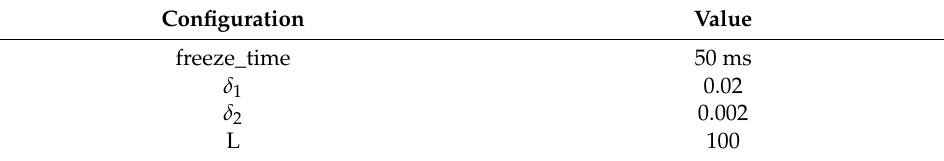
Table 4. BLUE configuration.